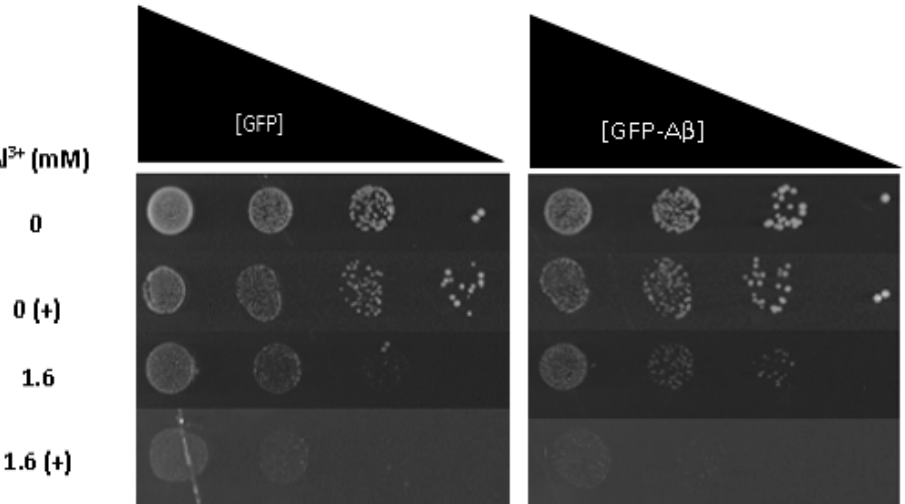
Figure 4. Growth of S. cerevisiae BY4743 [p416GPD.GFP] and BY4743 [p416GPD.GFP.A β ] cells on LPP medium containing 1.6 mM of Al 3+ and 2 mM Fe 3+ indicated by (+), plates were incubated at 30 °C for 7 days.